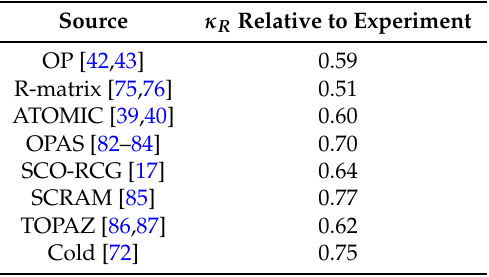
Table 4. κ R calculated with different opacity codes relative to